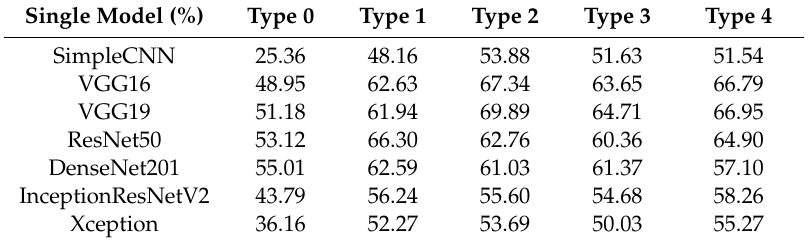
Figure 17. Confusion matrix for VGG19 with preprocessing of type 2 without data augmentation. Table 4. Classification performance of the CNNs without data augmentation under transfer learning (10 classes).